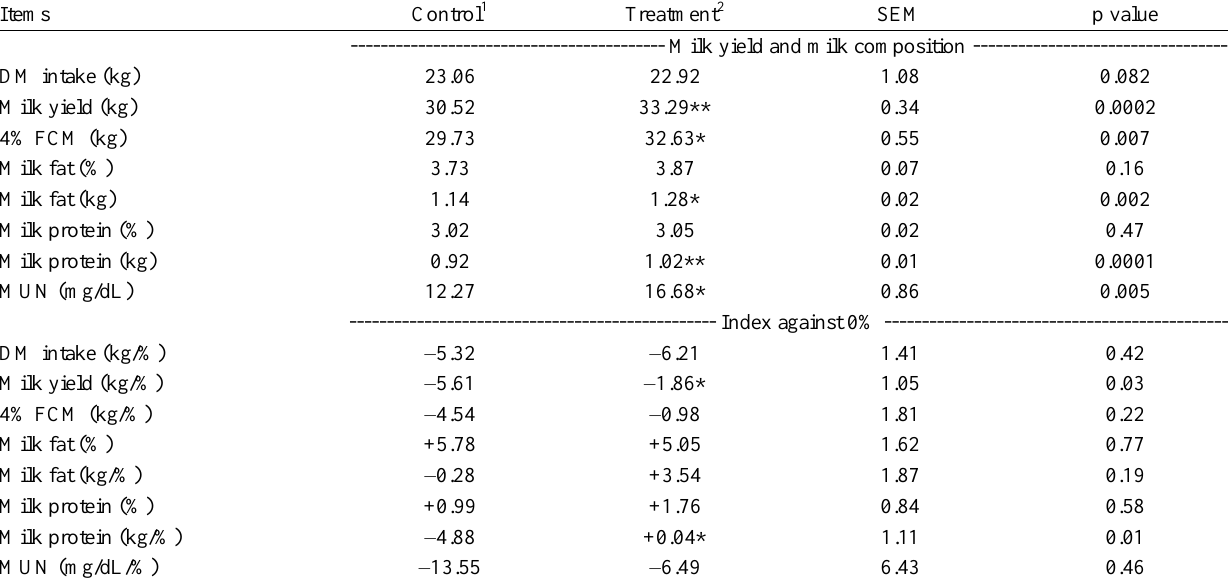
Table 4. Effect of RPAAs and RPF supplementation on DM intake, milk yield and milk composition in mid-lactating Holstein-Frisian dairy cows Items